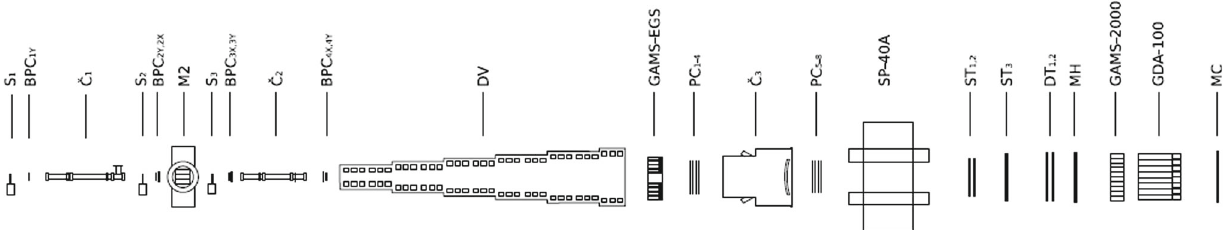
Fig. 2 OKA setup. The particle beam goes from left to right